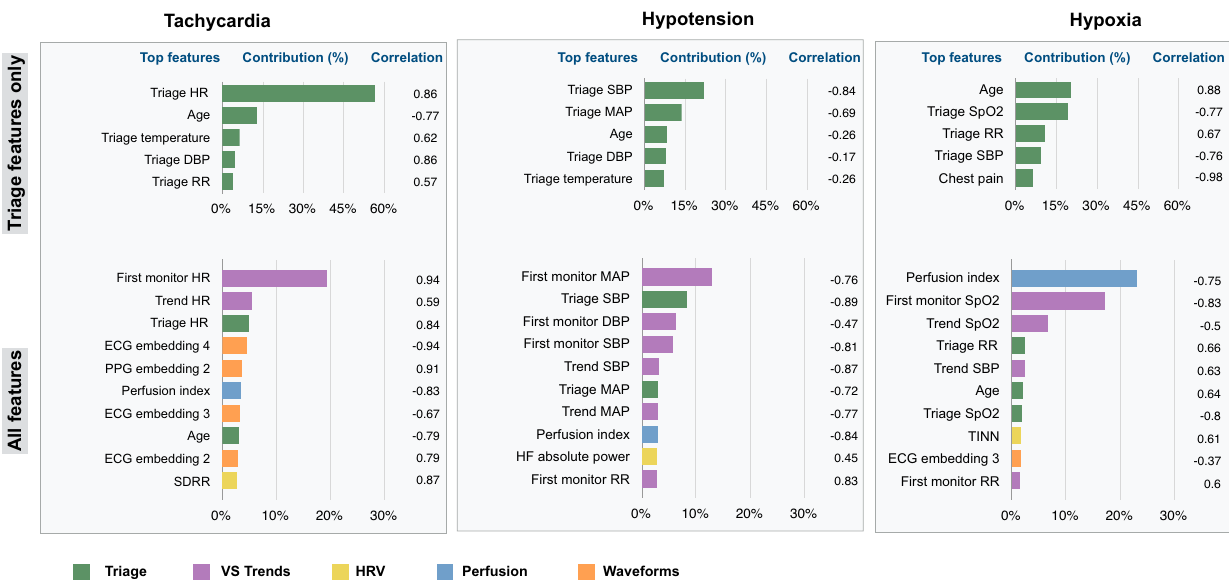
Fig. 3 Contribution of feature types to model predictions. Mean SHAP importance values were calculated for each feature in the baseline triage-only and fully featured models for all three tasks (see also Supplementary Table 11). Contribution (%) represents the relative weight of a given feature in the model ’ s prediction. Pearson ’ s correlation coef fi cients represent the extent to which a higher feature value contributes to a positive prediction as assessed through SHAP